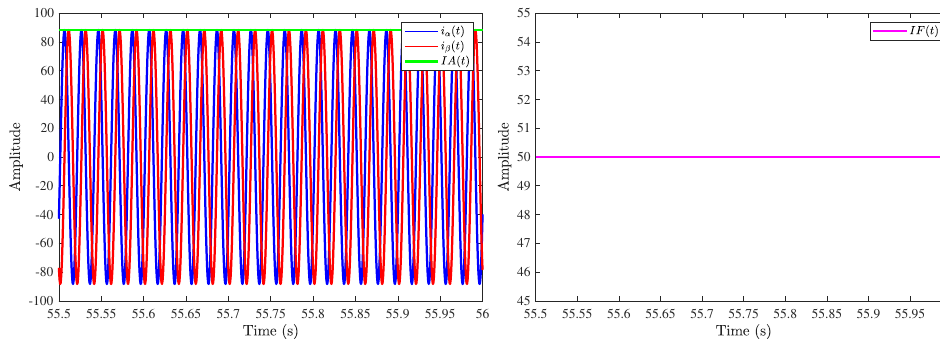
Figure 10. Simulated currents in the Concordia reference frame, from 55.5 to 56 s.